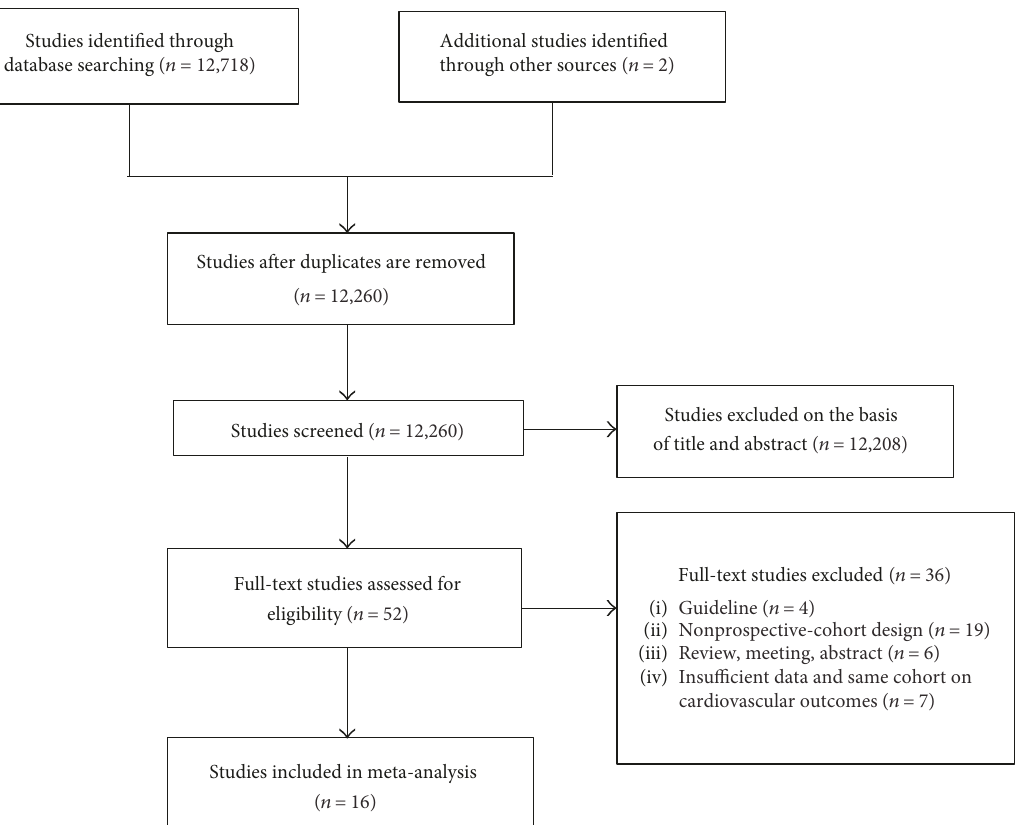
Figure 1: Flow chart for study